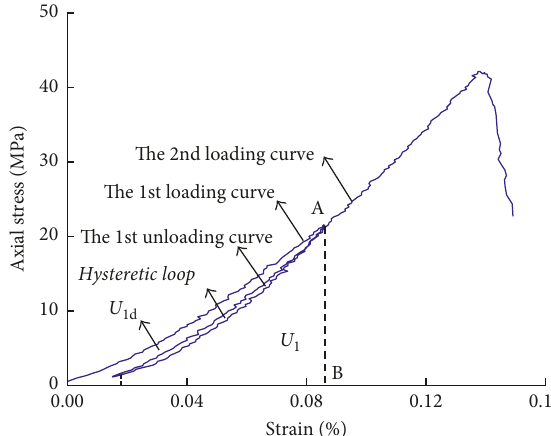
Figure 9: Schematic of energy calculation during loading- unloading